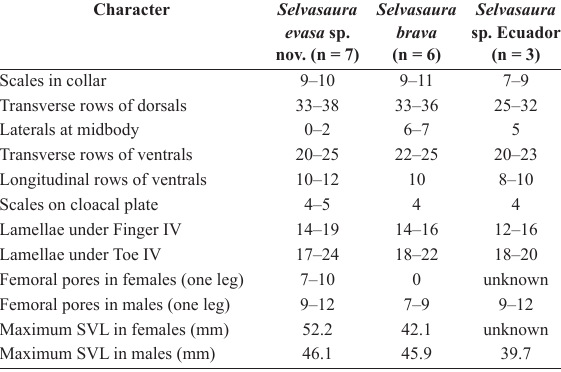
Table 1. Variation in scutellation and sexual dimorphism in SVL (mm) of Selvasaura evasa sp. nov. and its congeners, S. brava and S. sp.